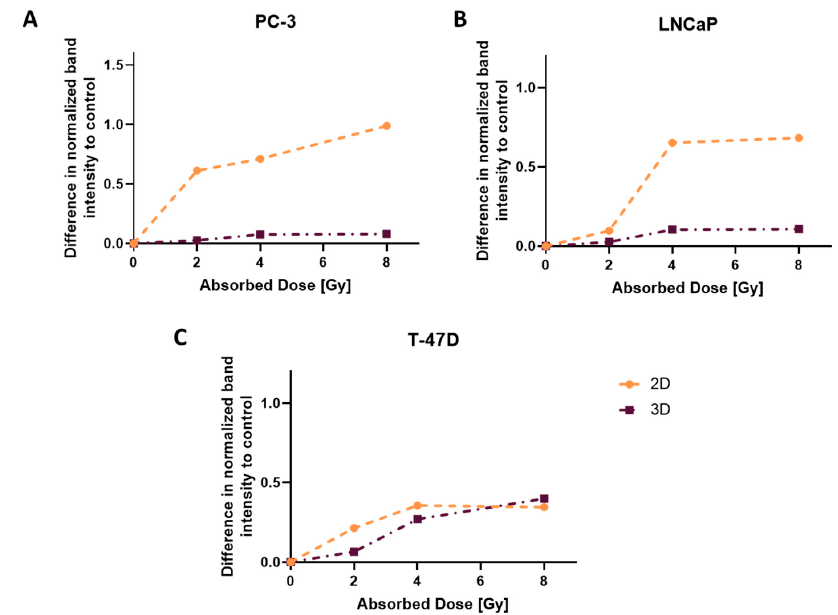
Figure 6. Differences in normalized γ H2AX band intensity to control, compared between 2D and 3D directly after irradiation for ( A ) PC-3, ( B ) LNCaP and ( C ) T-47D.